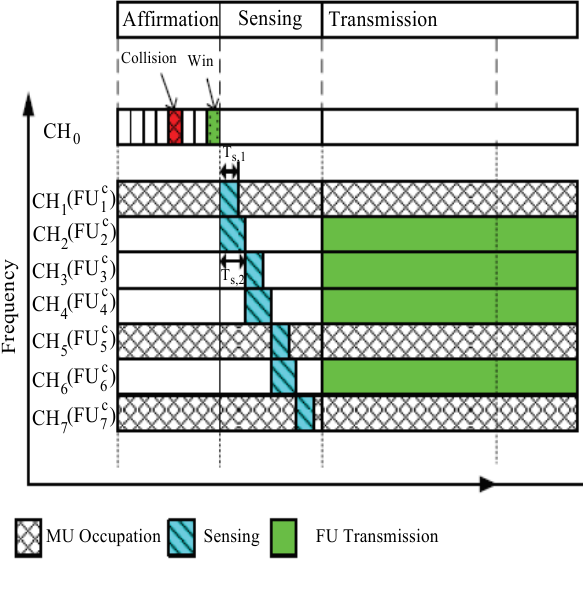
Fig. 4: Different Phases of MAC Protocol